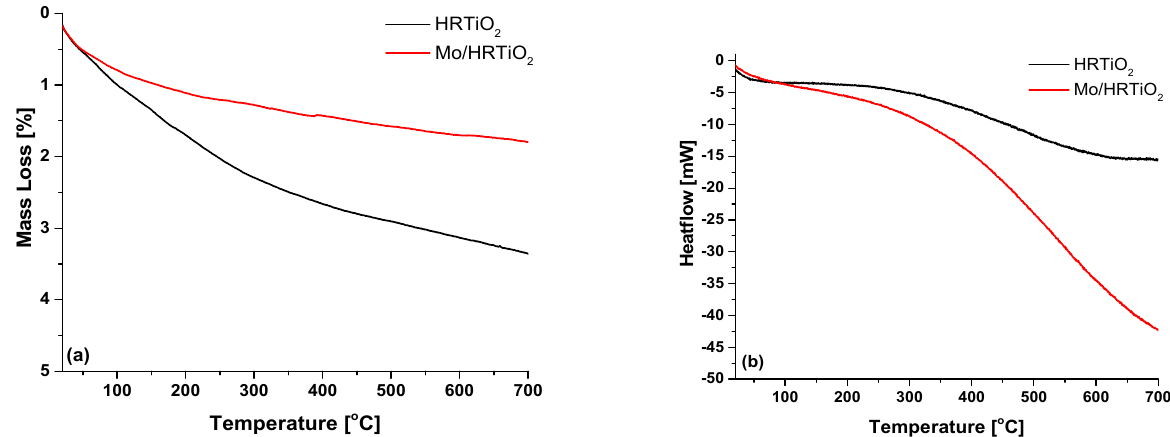
Figure 1. Thermogravimetric analysis shows respective: ( a ) Mass-loss (%), and ( b ) heat flow content of unmodified HRTiO 2 (black line) and Mo/HRTiO 2 (red line) for sample materials. The crystal phase composition/crystallinity and average particle size of Mo/HRTiO 2 and the unmodified HRTiO 2 were respectively measured and analyzed by X-ray diffraction (XRD) and transmission electron microscope (TEM). The identified crystal phase structures known for the pristine TiO 2 material were similar and matched in the modified sample material (Figure 2a). Mixed anatase and rutile pristine TiO 2 peak phases of {101}, {103}, {004}, {112}, {200}, {105}, {211}, {204}, and {116} corresponding with respective angle reflections of 2 θ = 25.39 ◦ , 36.9 ◦ , 37.79 ◦ , 38.57 ◦ , 48.07 ◦ , 53.89 ◦ , 55.07 ◦ , 62.69 ◦ , and 68.76 ◦ , and indexed according to JCPDS card no. 01-071-168 were identified and matched in both the unmodified and modified samples. The intensities of these peaks and their positions agreed